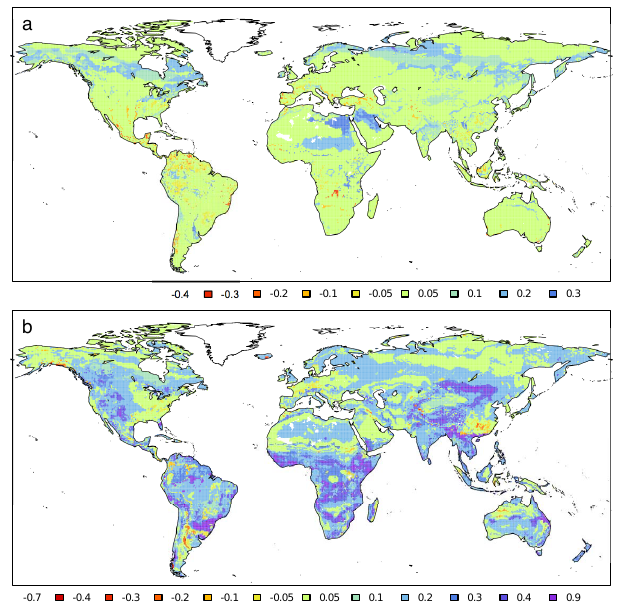
Figure 4. Difference in NPP t between target (future climate and land use) and reference (current) conditions using (a) the NCEAS model (limited NPP) or (b) the LPJ model (enhanced NPP) for NPP 0